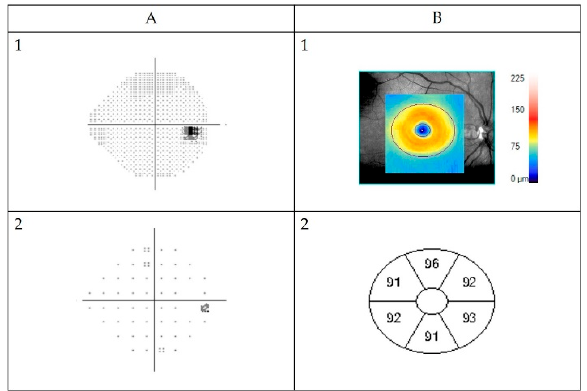
Figure 1. Example of normal automated Humphrey Field Analyzer visual field (VF) measurement ( A ) and GC ‐ IPL (ganglion cell + inner plexiform layer) scan obtained by Zeiss Cirrus high ‐ definition optical coherence tomography ( B ) from a healthy right eye. ( A1 ) Visual field presented in grey scale, black indicating visual field defects. The black spot on the right side is the normal “blind spot”, representing the location of the optic nerve head, 15° nasally in the retina. Below pattern deviation plot ( A2 ). This is in fact a plot of the probability of each point change being normal. If less than 0.5% (indicated by the solid black squares), then the point change is highly unlikely to be normal. Visual field sensitivity given for each eye as percentage of intact visual field (Visual Field Index). ( B1 ) Color ‐ coded topography of the macular GC ‐ IPL layer with blue color indicating thinning. Below ( B2 ) sectoral maps showing macular GC ‐ IPL thicknesses in superiotemporal, superior, superionasal, inferionasal, inferior, and inferiotemporal sectors. Average GC ‐ IPL values as well as minimum GC ‐ IPL for each eye (microns).